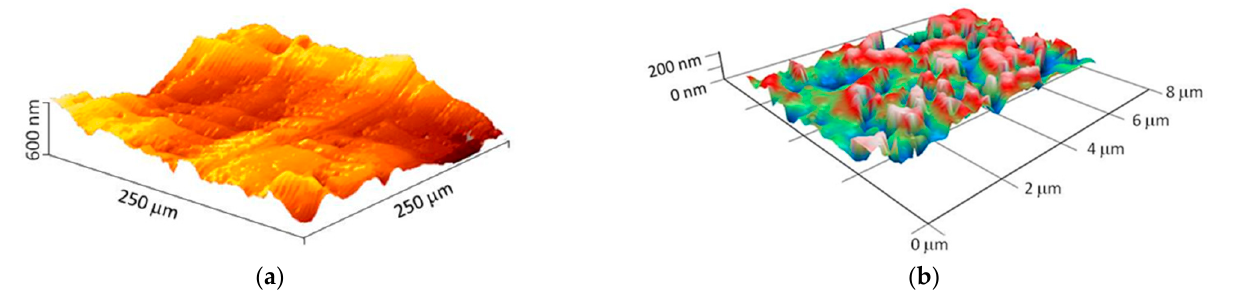
Figure 3. Data of nano-scale properties of the Ti-20Nb-10Ta-5Zr alloy surface: ( a ) AFM data; ( b ) MIM data.